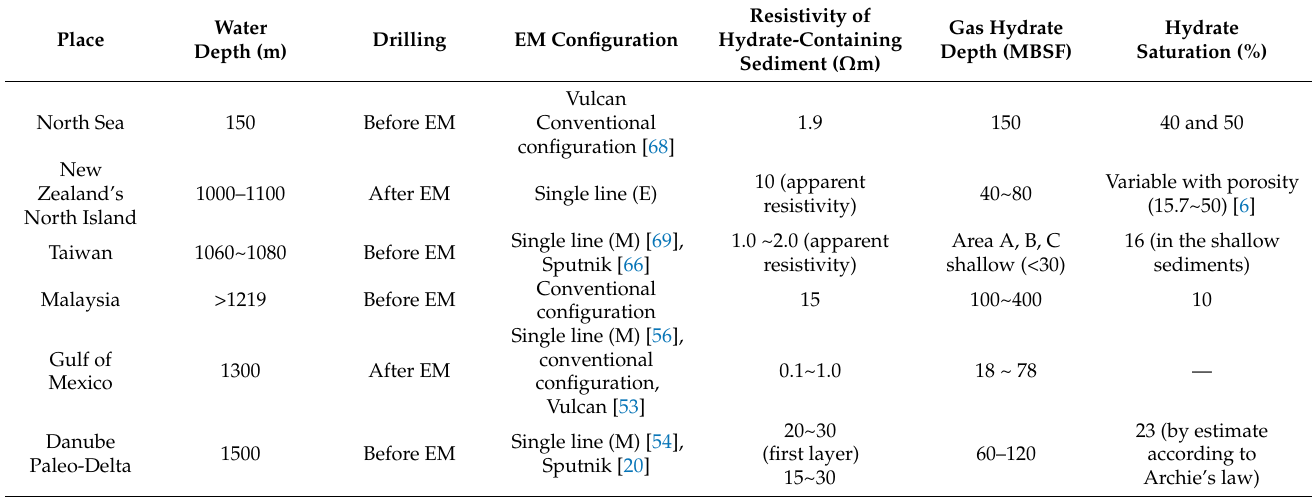
Table 2. Geophysical exploration and gas hydrate information at several